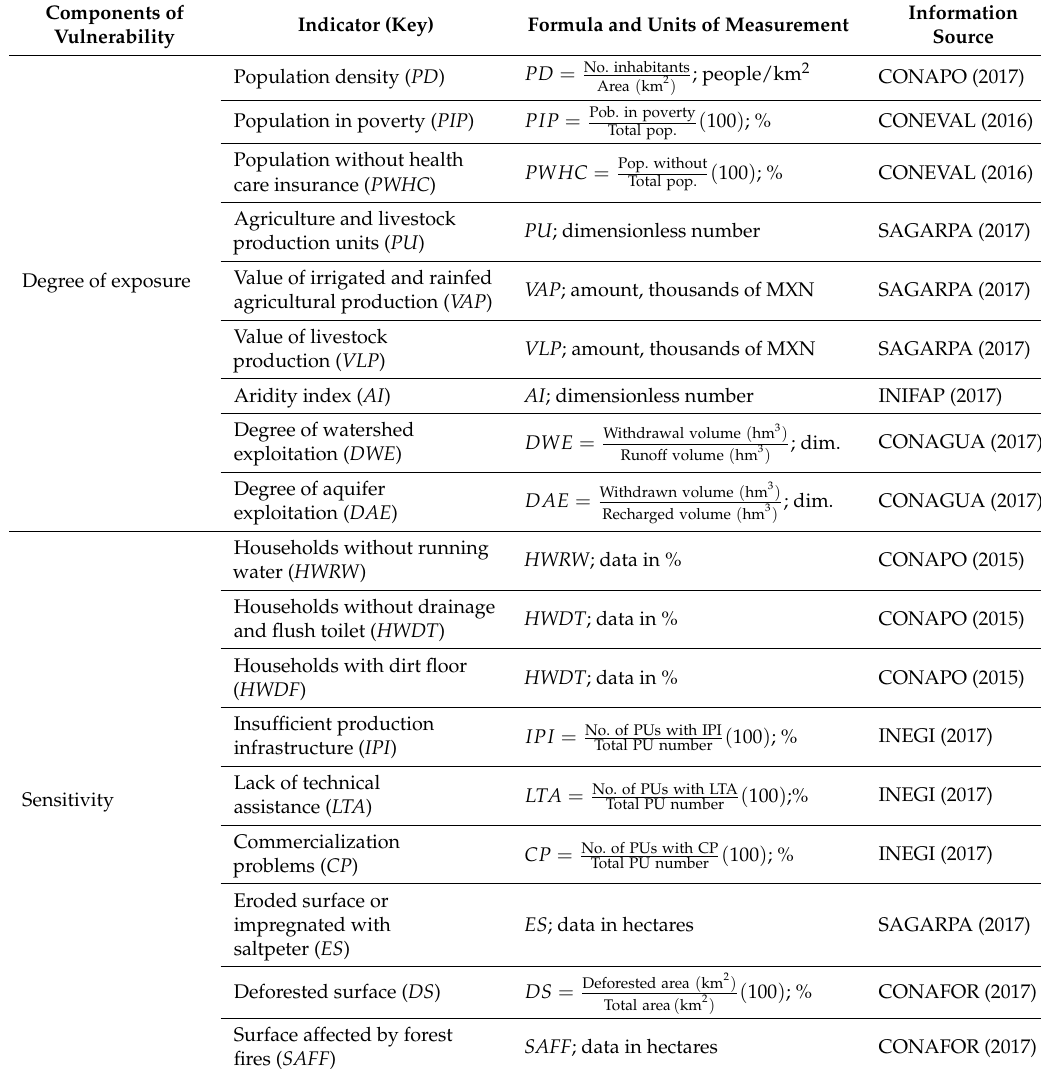
Table 5. Formulas and sources of information to calculate